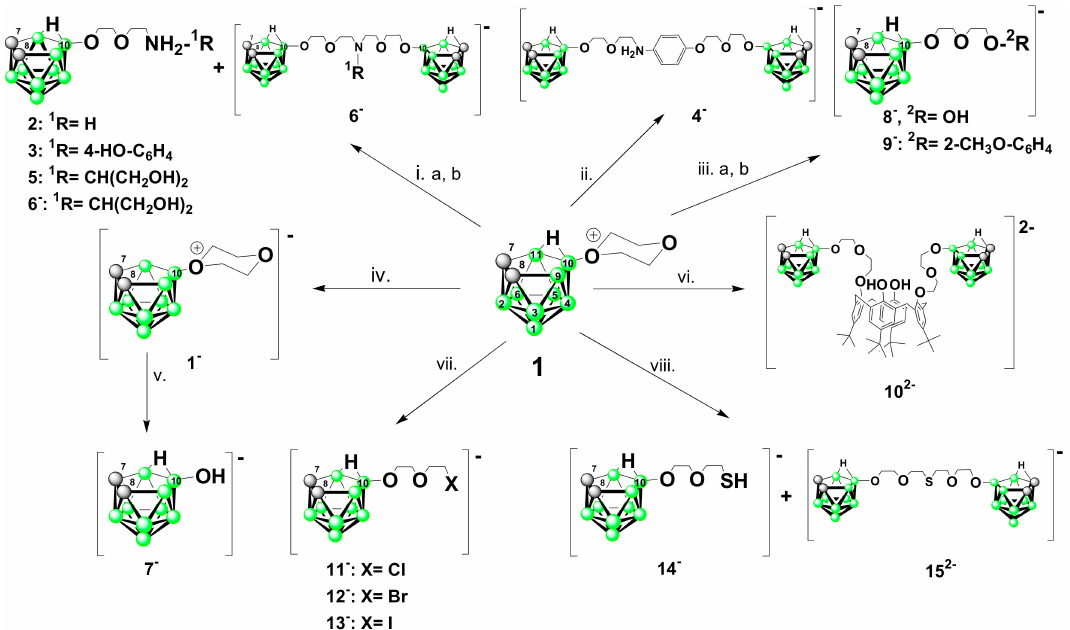
Scheme 2. Reaction pathways observed in this study for cleavage of the ring in 1 by various nucleophiles; i. Amine in an excess, (a) THF for 2 , ACE ® pressure flask, (b) for 3, THF r.t.; ii. 1-HO-C 6 H 4 -4-NH 2, K 2 CO 3 in CH 3 CN, 80 ◦ C; iii. (a) for 8 − : KOH water-ether, r.t. (b) for 9 − : K 2 CO 3 , 1-HO-2-CH 3 O-C 6 H 4